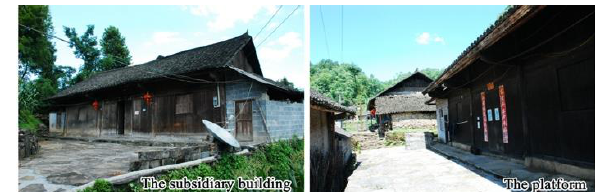
Figure 5. The low courtyard walls and the courtyard door.